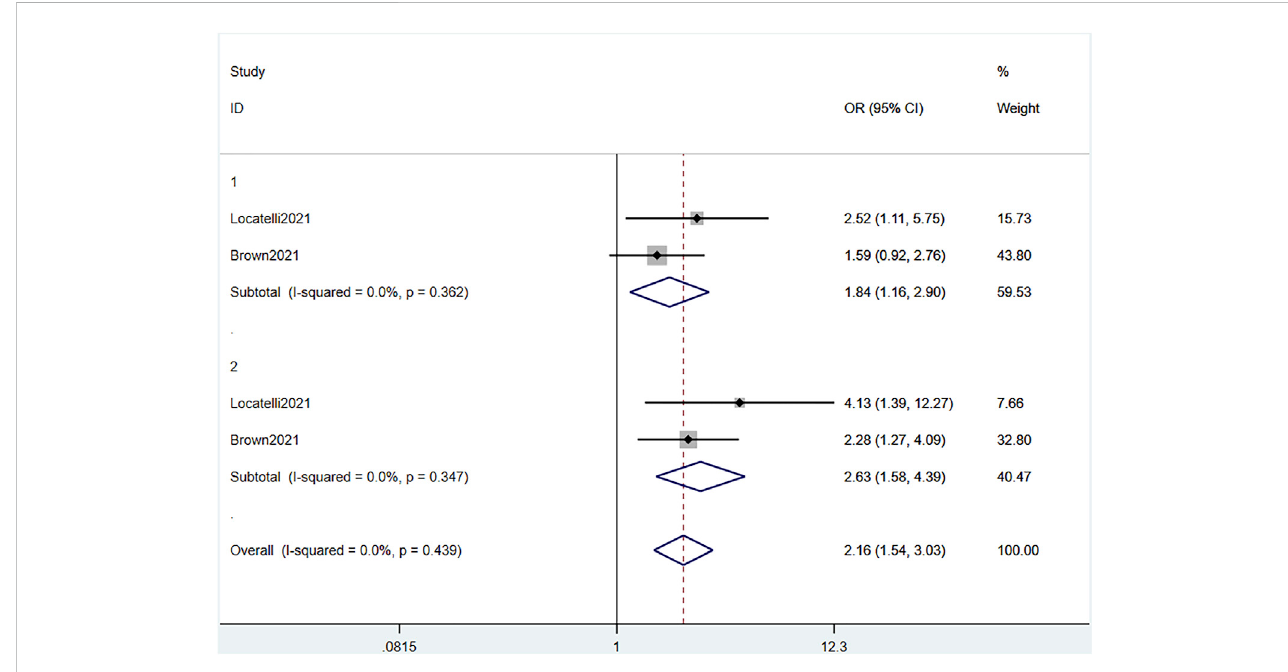
FIGURE 5 ForestplotofEFS(RCTs).EFS,event-freesurvival;RCTs,randomizedclinicaltrials;OR:oddsratio;1,1-year;2,2-year;3,3-year.Thesizeoftherectangle at the center of the horizontal bar is proportional to the weight of the given study. The diamond at the bottom indicates the pooled OR.